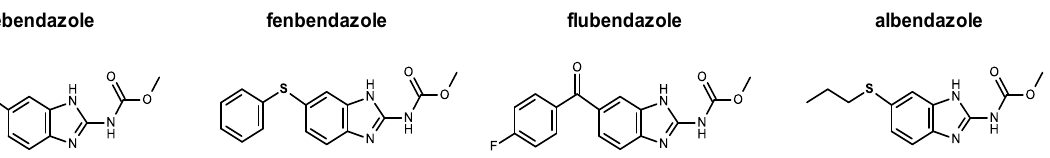
Figure 1. Chemical structures of various benzimidazoles with anticancer activity.